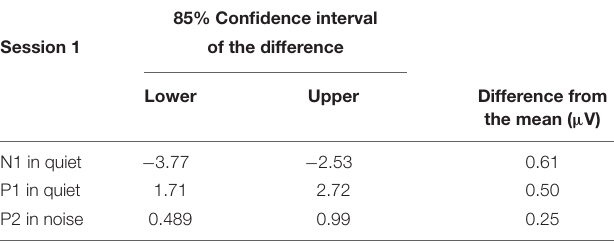
TABLE 3 | Confidence interval of the difference.